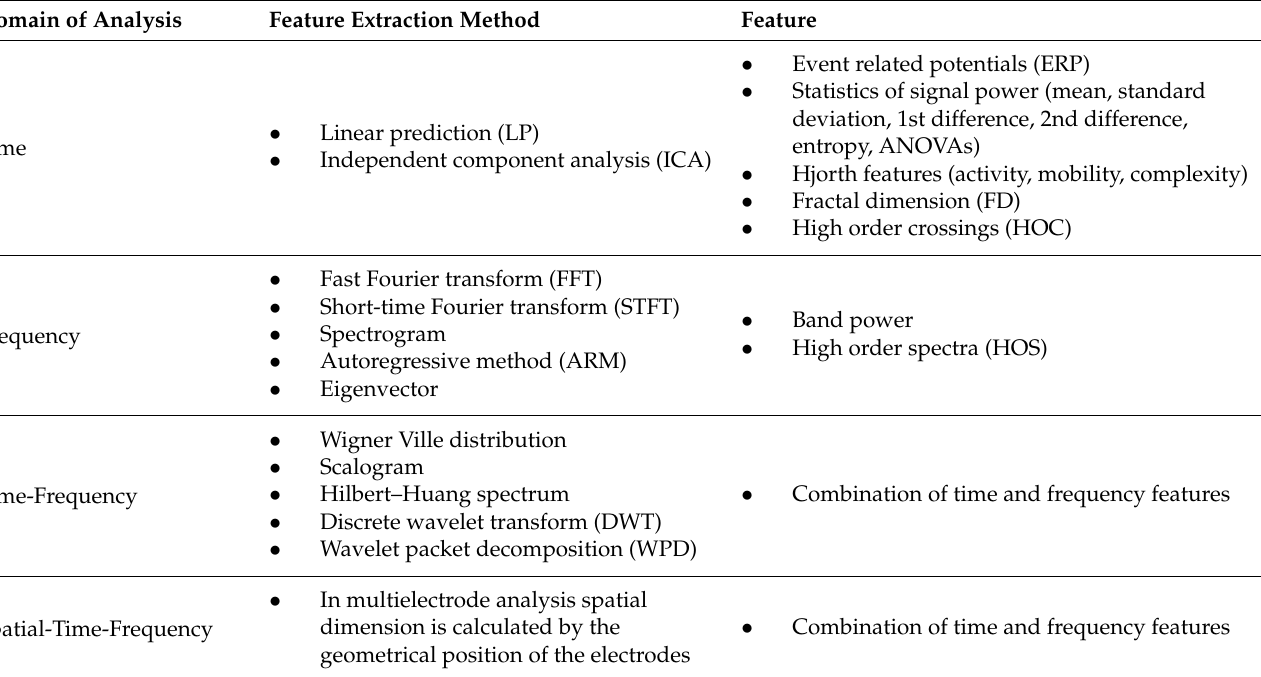
Table 3. Domains, extraction methods and features of EEG